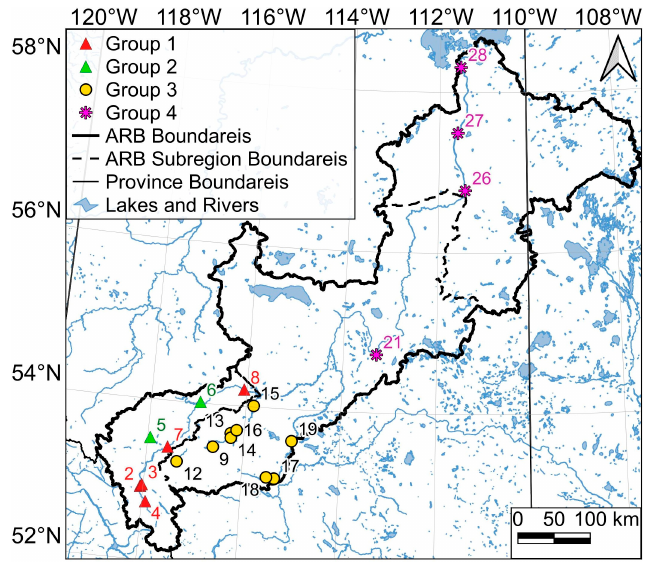
Figure 7. Three groups were determined using the monthly stream fl ow correlations shown in Figure 6. Each group consisted of monthly stream fl ows with a correlation of 0.95 or higher. Group 1: